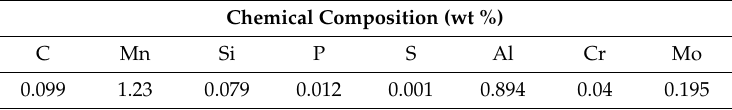
Table 1. Chemical composition of DP600 steel.